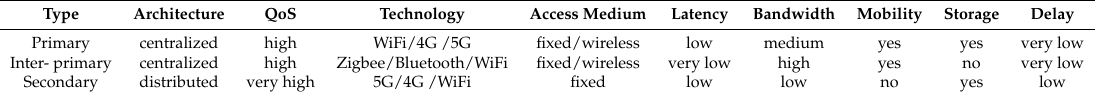
Table 2. Characteristics of Blockchain and Fog-based Architecture Network (BFAN).